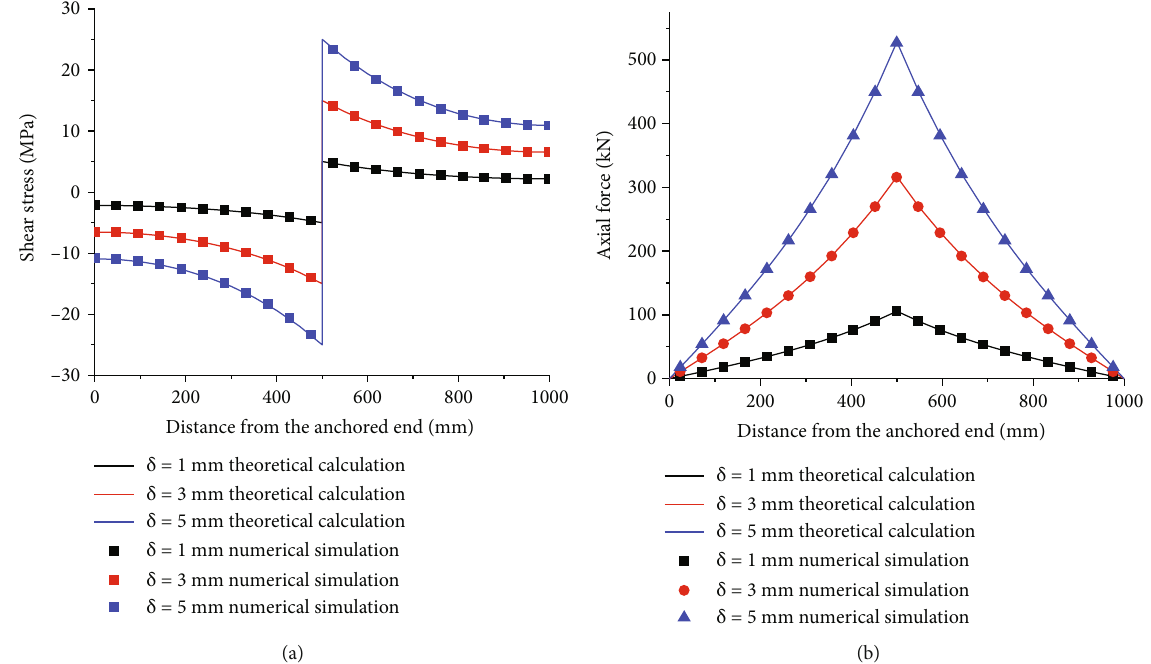
Figure 5: (a)The axial force and (b) interfacial shear stress curves of theoretical calculation and numerical simulation results when δ = 1 , 3, and 5 mm.